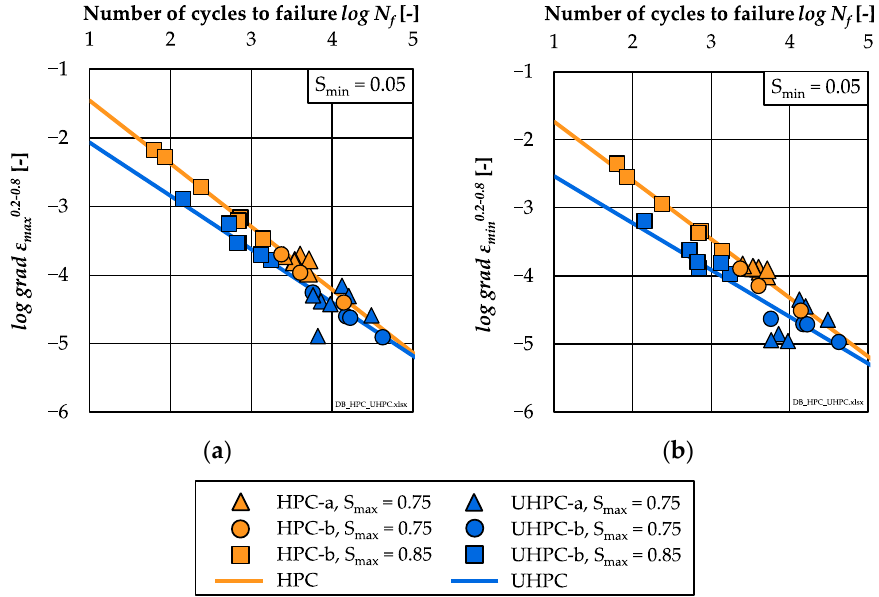
Figure 7. Log. gradients of strain in phase II related to log. numbers of cycles to failure of HPC and UHPC; ( a ) gradients of maximum strain and ( b ) gradients of minimum strain.